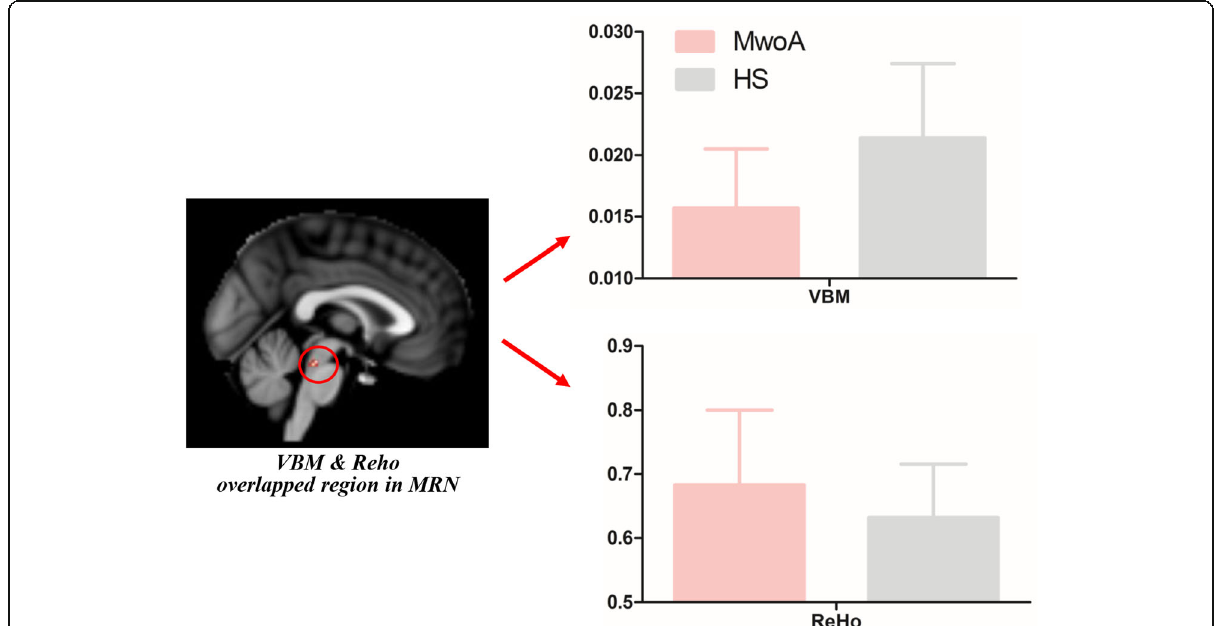
Fig. 2 The VBM and Reho values of the overlapped region in MRN in MwoA patients and healthy subjects. MwoA had decreased gray matter volume but increased Reho values in the median raphe nuclei compared with healthy subjects. Pearson correlation analysis showed that there was no association between volume or Reho values of the MRN and headache frequency, headache intensity or disease duration, SAS and SDS in MwoA patients. HS, healthy subjects; MwoA, migraine without aura; Reho, regional homogeneity; MRN, median raphe nuclei; VBM,